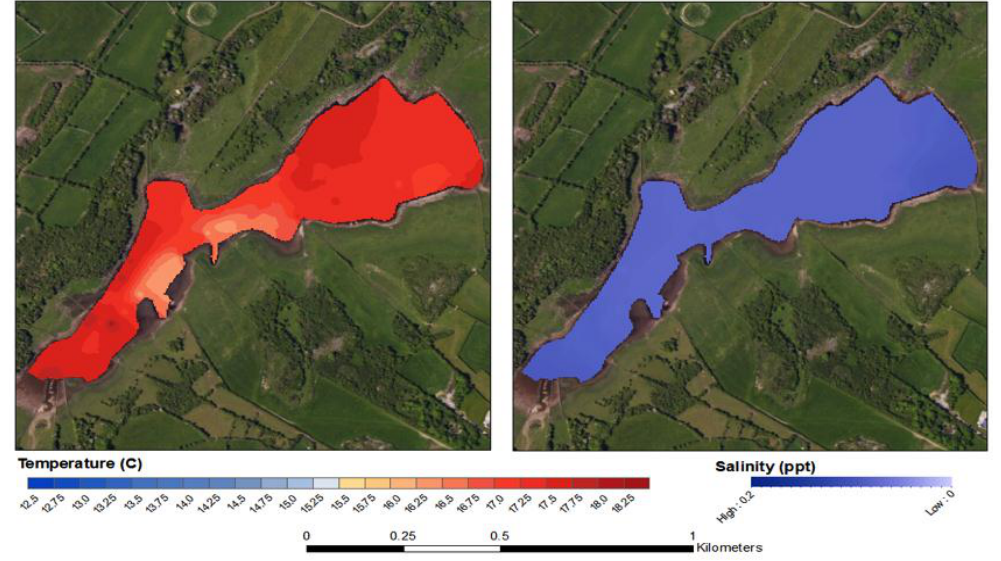
Figure 13. Surface temperature map ( A ) and Salinity map ( B ) of Caherglassuan Turlough.